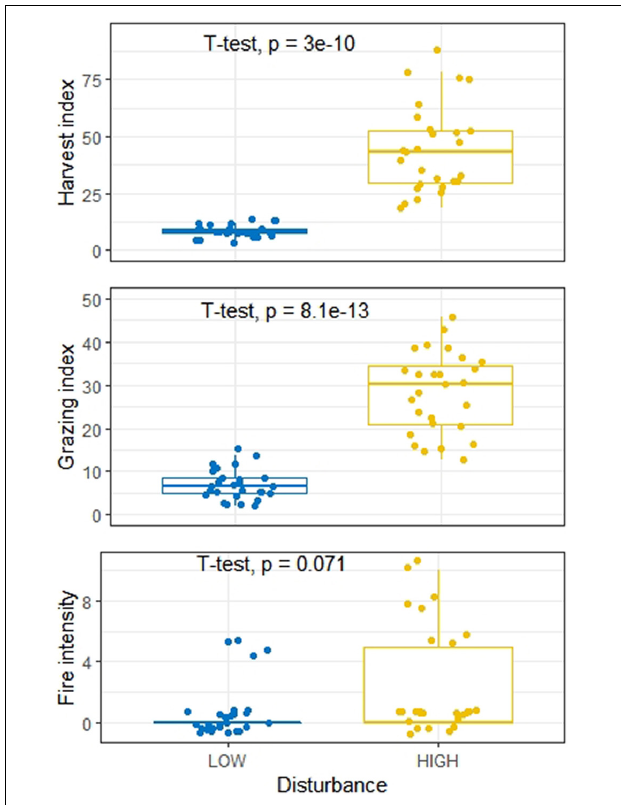
FIGURE 2 | Boxplot showing distribution of harvest index, grazing index, and fire intensity at low and high disturbed